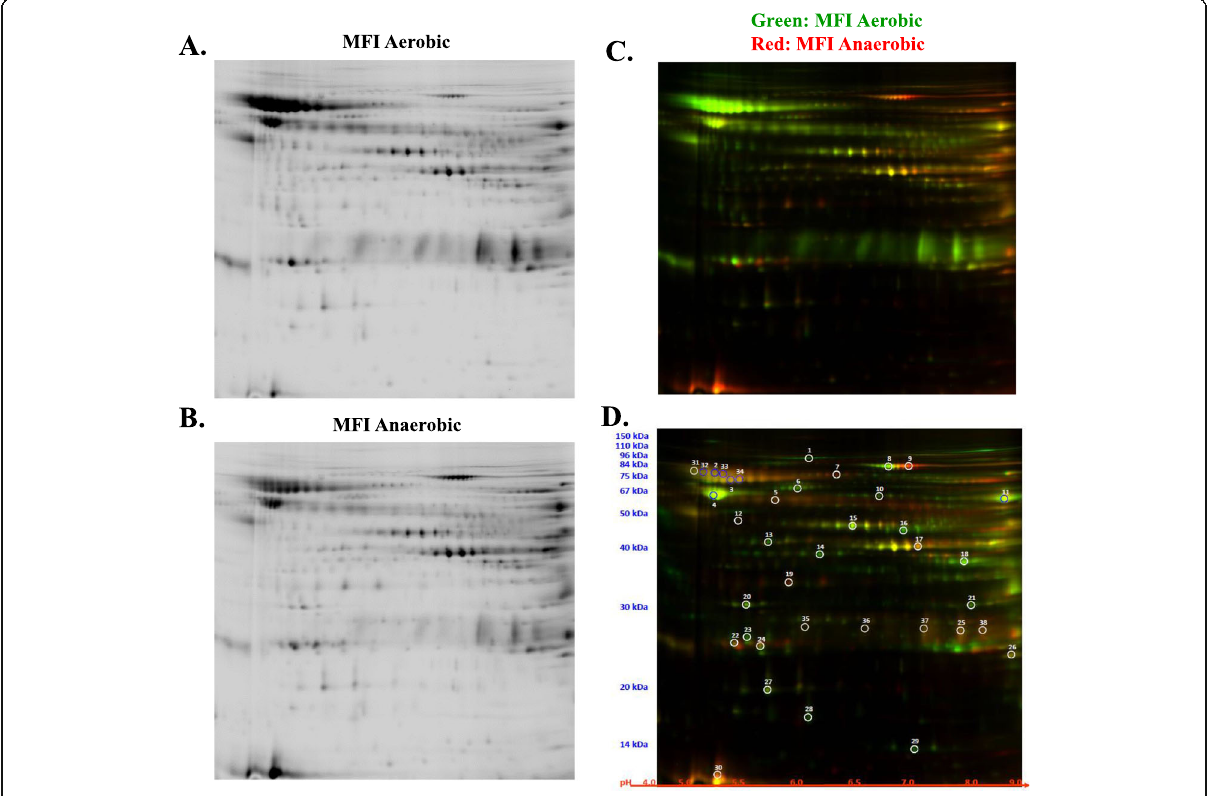
Fig. 2 a : 2D-Dige Triton X-114 hydrosoluble fractions of Mycoplasma fermentans MFI, grown in aerobic and b : anaerobic conditions. c : Superimposition of the signals generated by 2D-Dige Triton X-114 hydrosoluble fractions of MFI. Growing conditions are indicated in figure with red, anaerobic, and green, aerobic. d : 2D-Dige gel map of MFI hydrosoluble proteins showing the protein identification number obtained